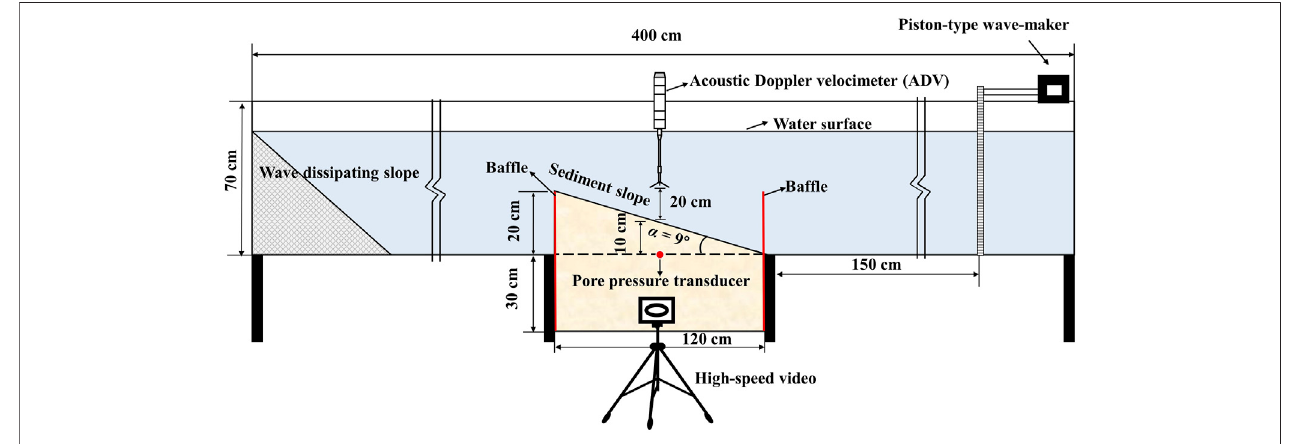
FIGURE 1 | Schematic of the experimental